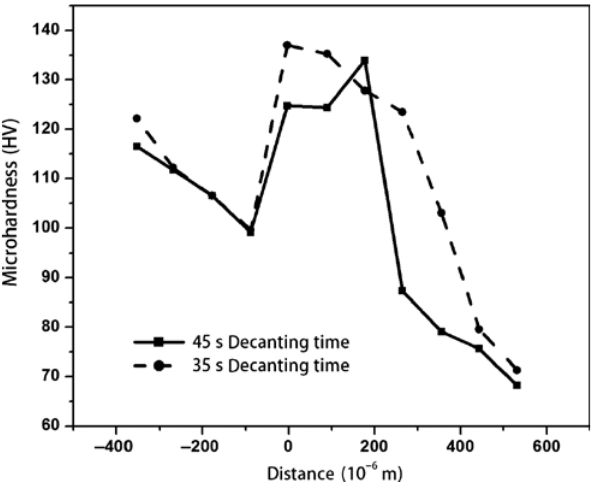
Figure 22: Variation of microhardness across the graded coating